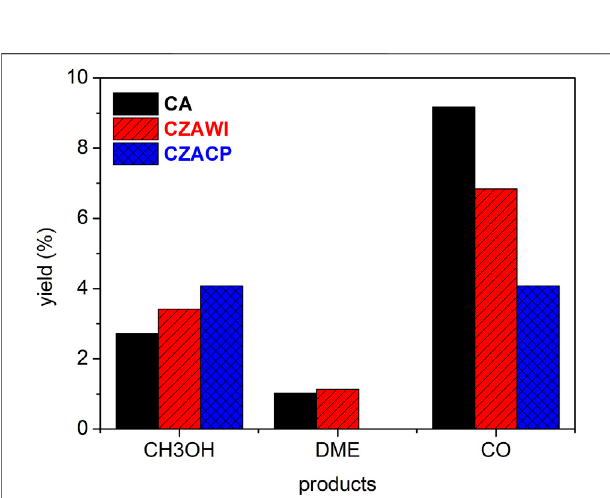
FIGURE 13 | Product yield at a steady